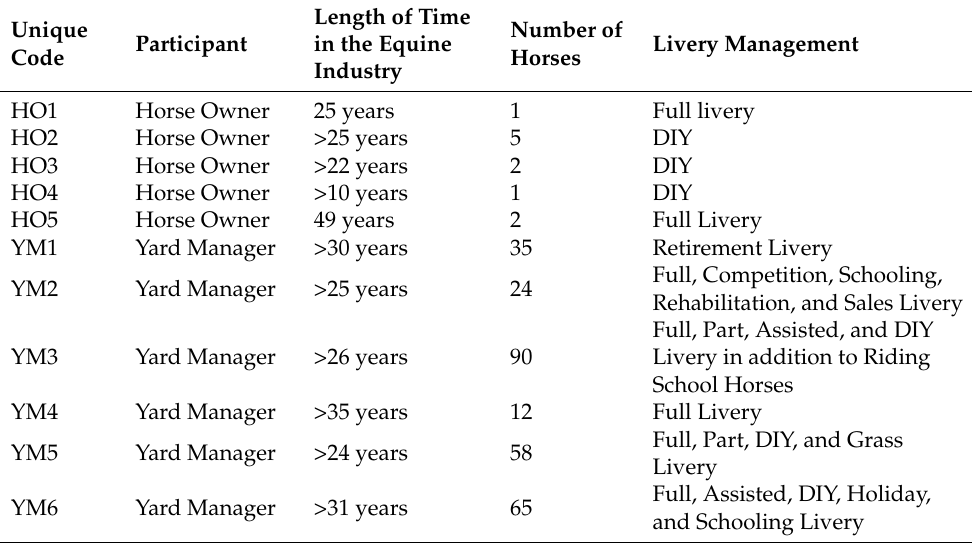
Table 2. Summary of participating horse owners ( n = 5) and yard managers ( n = 6) from England by length of time in the equine industry, number of horses, and livery